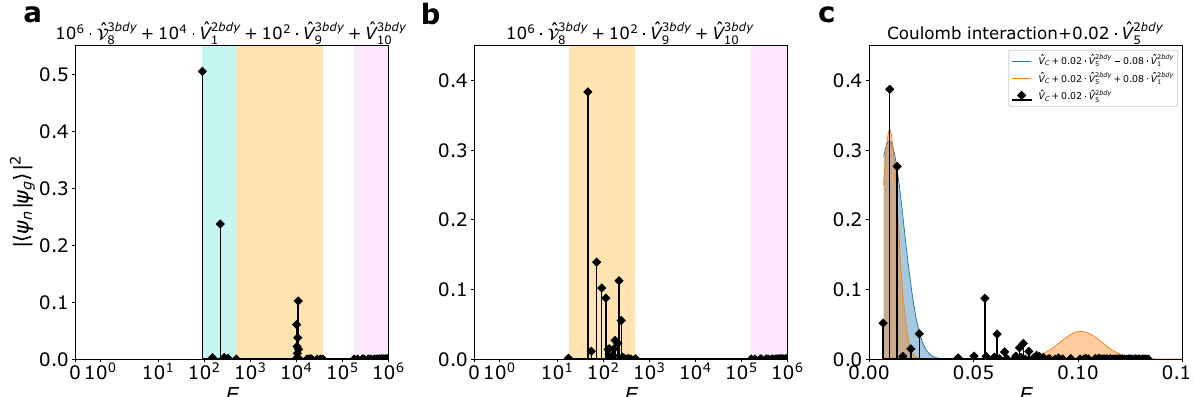
Fig. 6 | Spectral functions of the Pfaf fi an state at ν =1/4 with 8 electrons. a , b ModelHamiltonian with and without ^ V 2bdy 1 . The turquoise, the orange and the pink region denote H 2bdy 1 , the null space of ^ V 3bdy 8 and its complement